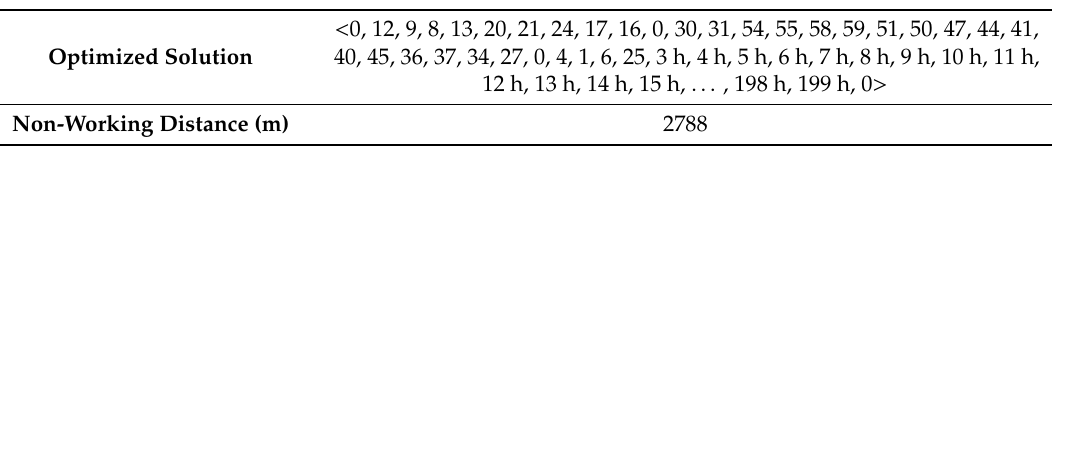
Table 12. The optimized plan for operation A, based on the proposed method in this study.